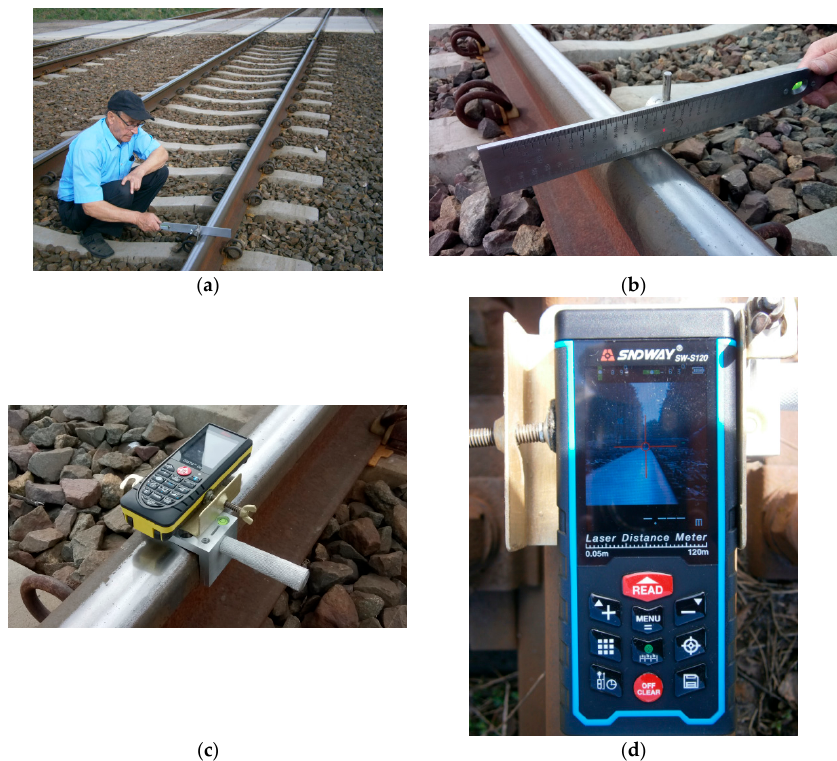
Figure 2. The Magnetic-Measuring Square for measuring versines (own photograph): ( a ) the lengths